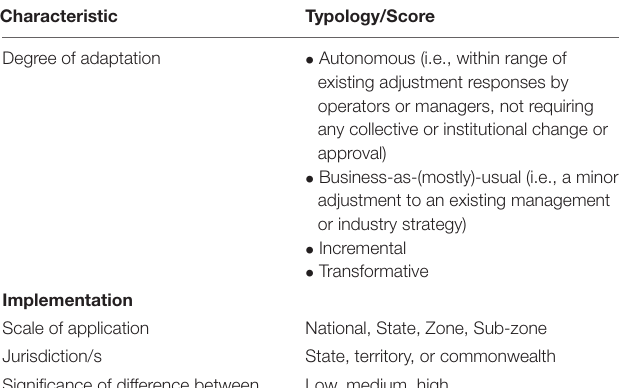
TABLE 1 | Characterization matrix used to identify the key attributes of adaptation options to specific climate-driven